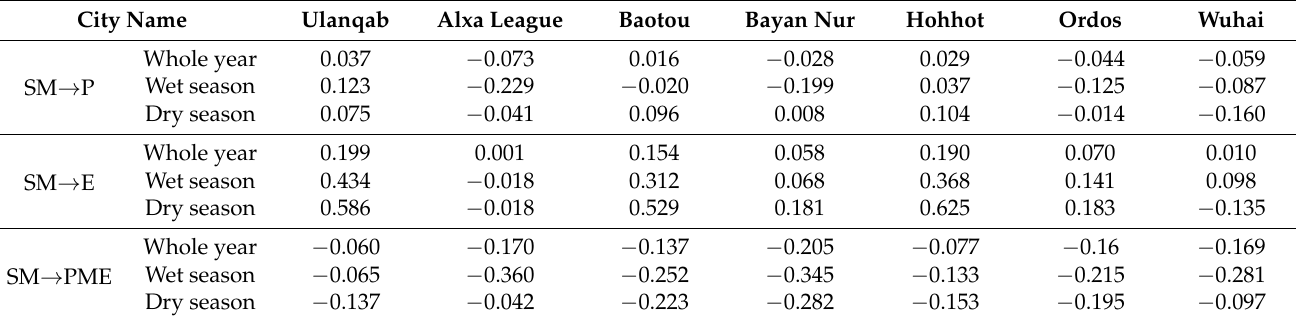
Figure 4. Impacts of the SM feedbacks on water availability during in the wet and dry seasons, as well as the whole year. ( a – i ), sensitivity coefficients for SM → precipitation (P) ( a – c ), SM → evapotran- spiration (E) ( d – f ) and soil moisture (SM) → precipitation minus evapotranspiration (PME) ( g – i ) identified, based on whole year ( a , d , g ), wet season ( b , e , h ) and dry season ( c , f , i ). Table 3. Soil moisture (SM) feedbacks on precipitation (P), evapotranspiration (E), and water avail- ability (PME) mean statistics in the wet and dry seasons, as well as the whole year, and seven leagues and cities.